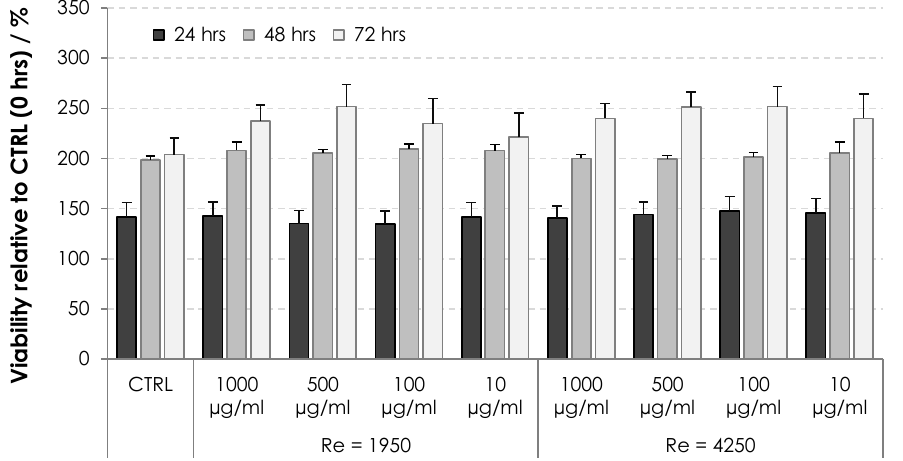
Figure 9. Viability of 3T3 cells subjected to dissolved HA textiles for 24, 48 and 72 h. Columns represent mean values and error bars the standard deviation.